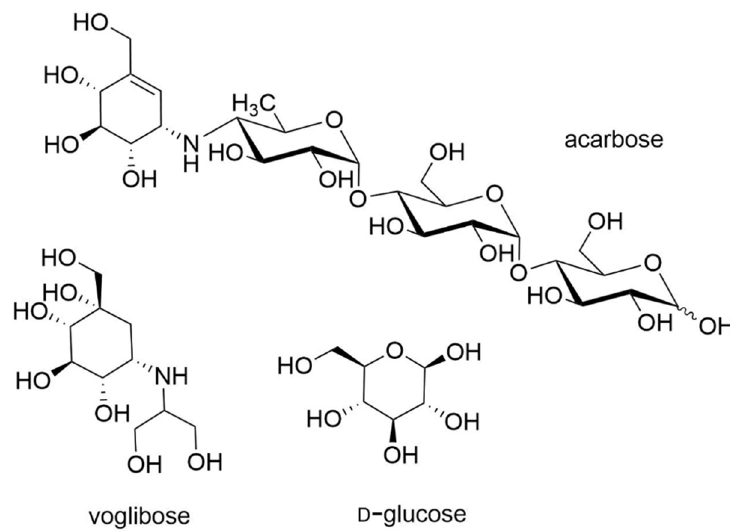
Figure 3. Carbohydrates evaluated as GAA PC.